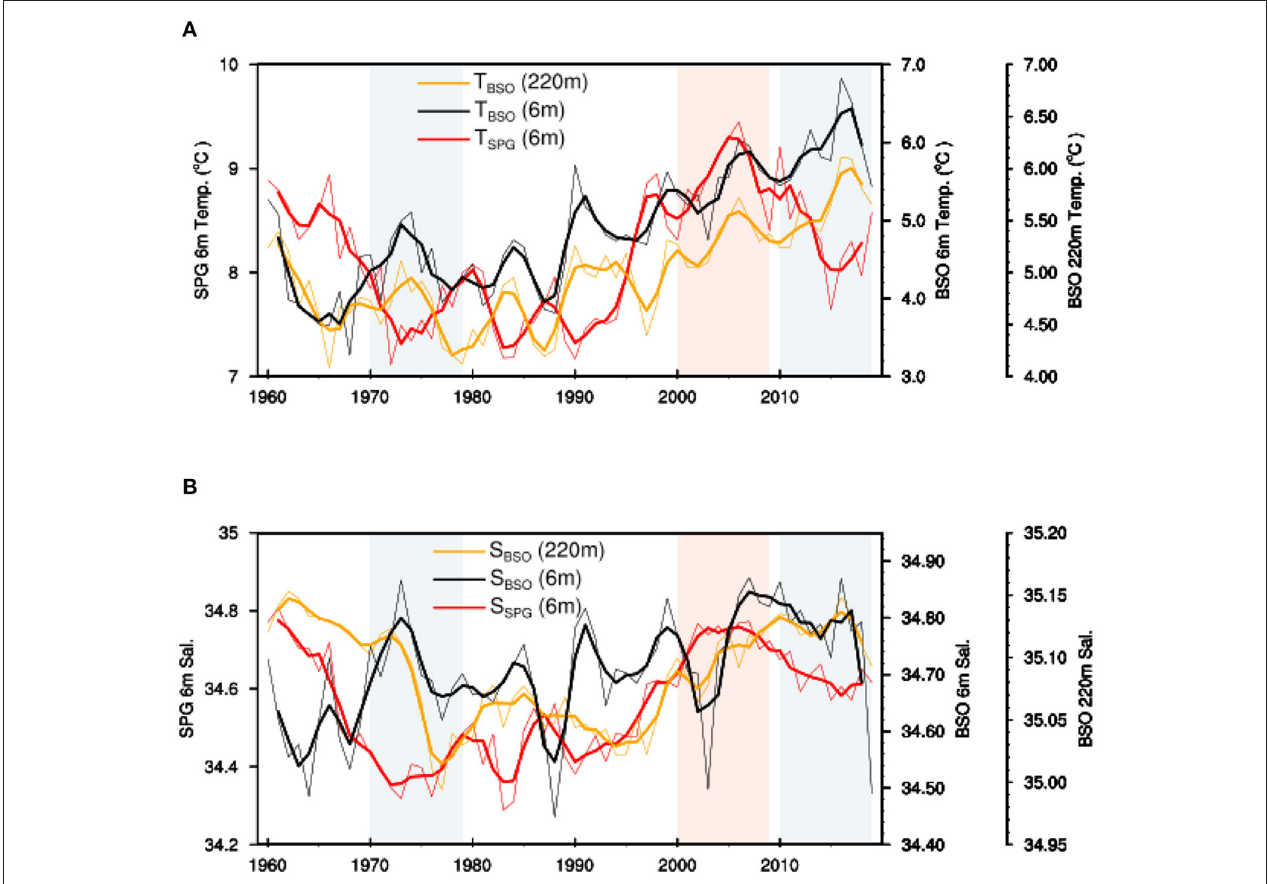
FIGURE 3 | Time series of modelled surface and sub-surface (A) temperature and (B) salinity in the North Atlantic Subpolar Gyre (-60:10 ◦ E, 50:62 ◦ N) and an the Barents Sea Opening (10:25 ◦ E, 70:78 ◦ N) for the period 1960–2019. For each of the time series shown, light lines are annual means and bold lines are three-year running mean values. The shaded time periods highlight the time periods four years after the respective decadal trends in the SPG.